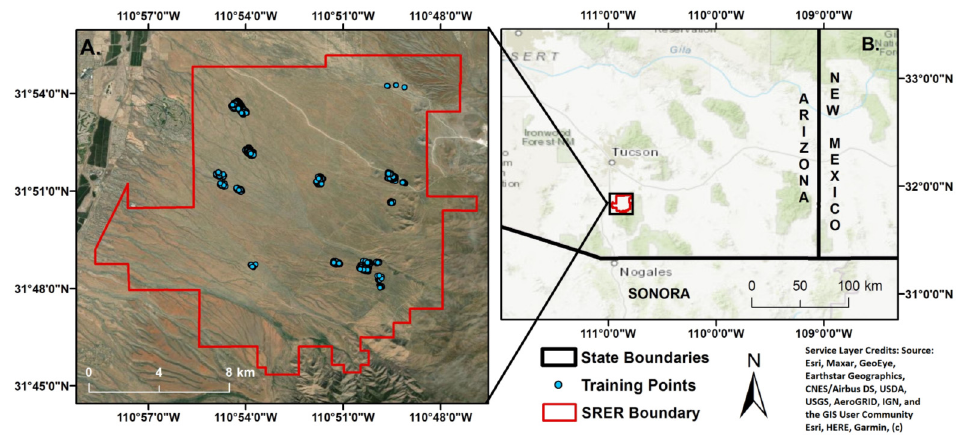
Figure 1. Location of Santa Rita Experimental Range (SRER), training points for the supervised species classification are symbolized in blue ( A ) and study area is outlined in red ( B ).